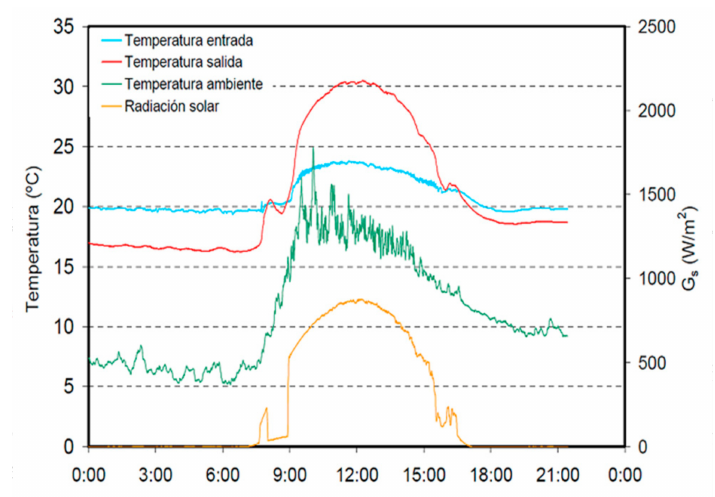
Figure 5. Heating values of the heat transfer fluid for one